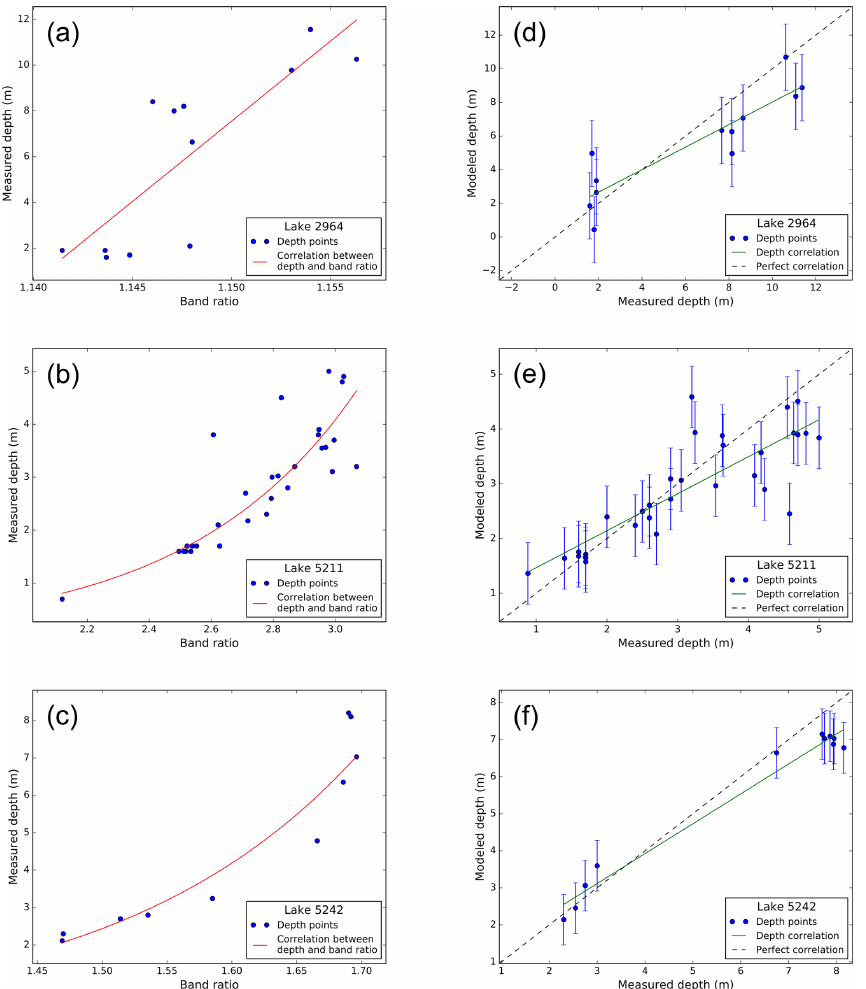
Figure 4. Coefficients of the trend lines between band ratios and measured depths (a–c) are used to tune the depth models for each lake. Different models (specified for each lake in Table 3) predicted lake depth best at each of these three lakes. The correlation between measured and modeled lake depths at three representative lakes (d–f) reveals an underestimation of deeper depths and overestimation of shallow depths. Error bars represent root mean squared error